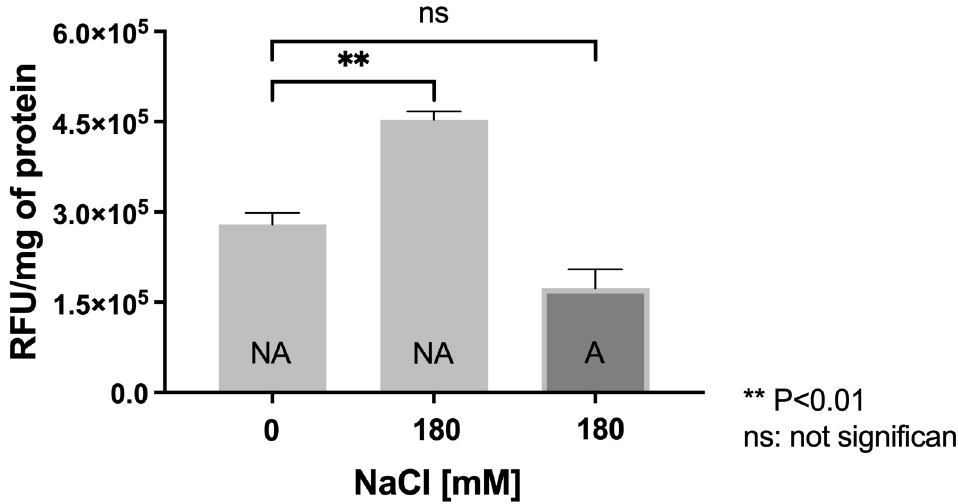
Fig 4. Effect of NaCl on ROS generation in L . ferriphilum . ROS were measured in adapted cells exposed to 180 mM NaCl (A) and non-adapted (NA) cells exposed to 0 or 180 mM NaCl. Cytoplasmic ROS content is expressed as relative fluorescence units (RFU) of the activated fluorescent probe H 2 DCFDA per mg of protein. The data represent the average of 3 independent experiments. Error bars represent standard deviation. Statistical analysis was carried out by ANOVA and a T